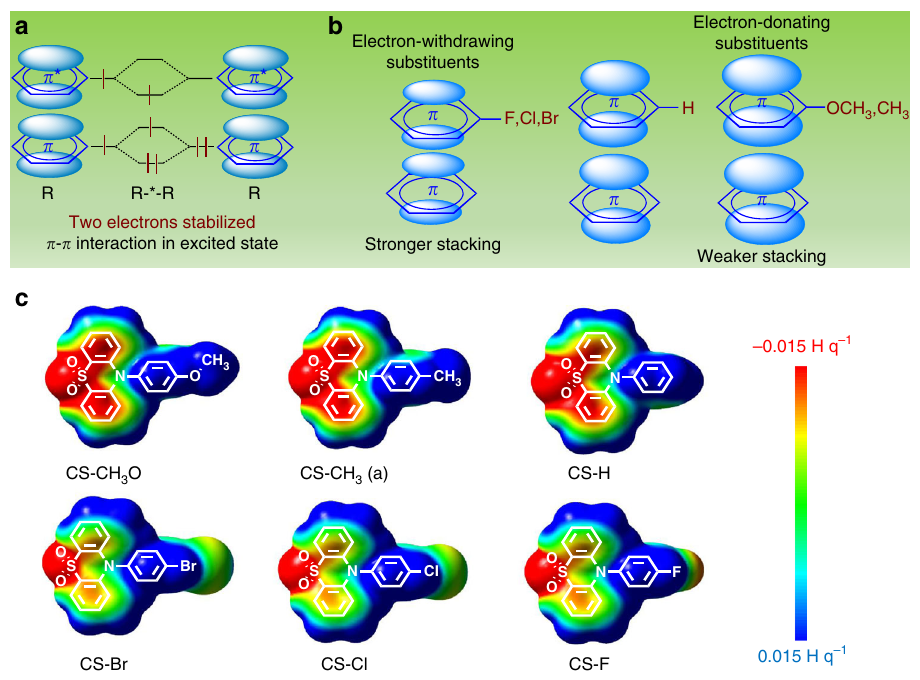
Fig. 4 The in fl uence of π – π interactions on the electron redistribution and RTP behavior. a The orbital interaction of π – π stacking in excited state: the electrons would redistribute in new orbitals for the π – π interactions, then three electrons are stabilized and one electron is destabilized, and thus the net stabilization is two electrons. b Depiction of the electrostatic model of substituent effects on π – π interactions from Hunter – Sanders model: electron- withdrawing substituents could enhance π – π interactions by decreasing the π -electron density of the substituted π -system and relieving the π – π repulsion, while electron-donating substituents hinder π – π stacking through the opposite mechanism. c Difference electrostatic potential (ESP) analysis of isolated CS-CH 3 O, CS-CH 3 (a), CS-H, CS-Br, CS-Cl, and CS-F. The potential energy range is − 0.015 to 0.015 H q -1 for all surfaces shown, red indicates areas with dense electron density, yellow for normal, while blue areas suggest less electron